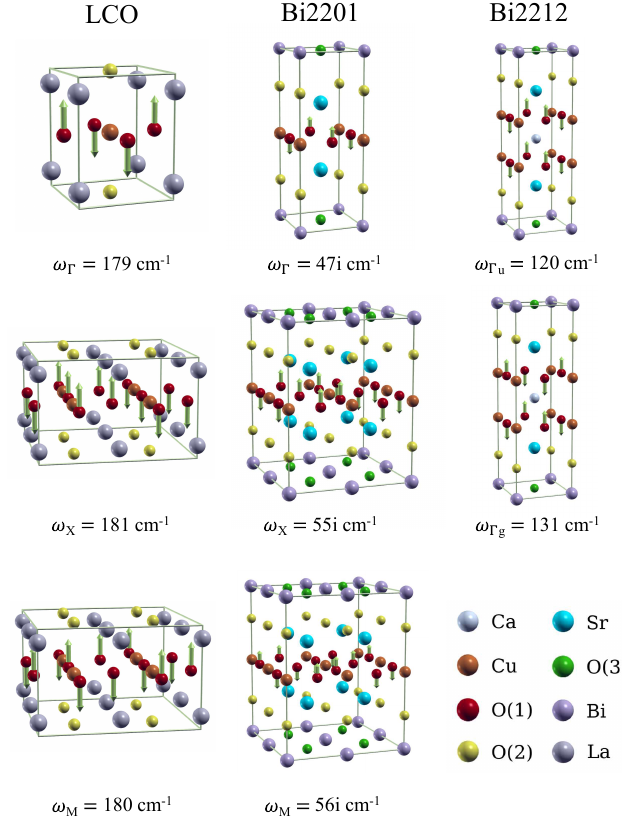
Figure 1: Cu-O bond buckling modes for La Bi Sr CaCu O (Bi2212) at the Γ , X and M points in the Brillouin zone ( Γ -only for 2 2 2 8 Bi2212). Note that the buckling modes for Bi2201 frequencies are imaginary at all three points, indicating a structural instability across the Brillouin